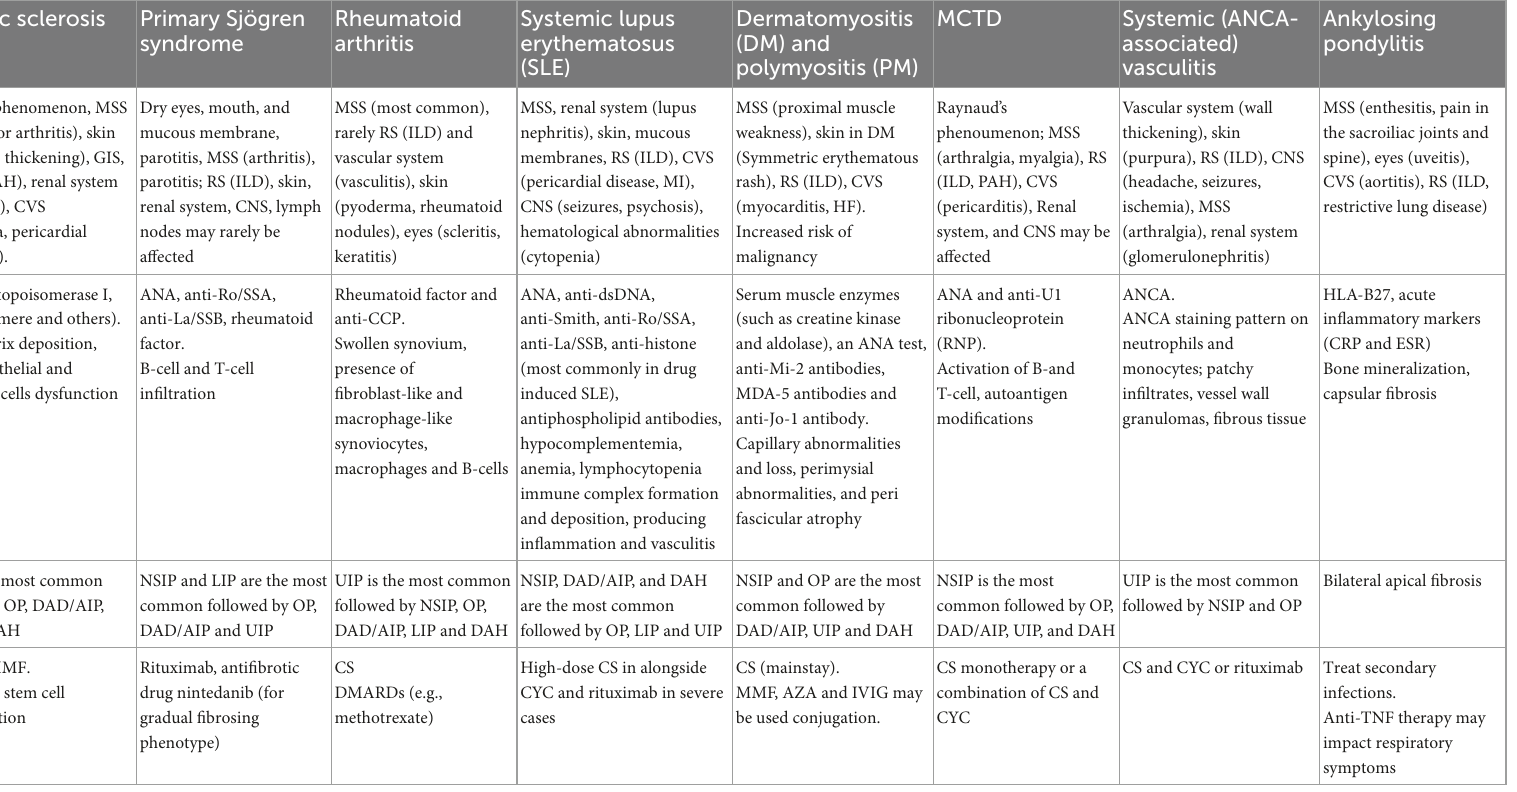
TABLE 1 Summary of CTD-associated lung